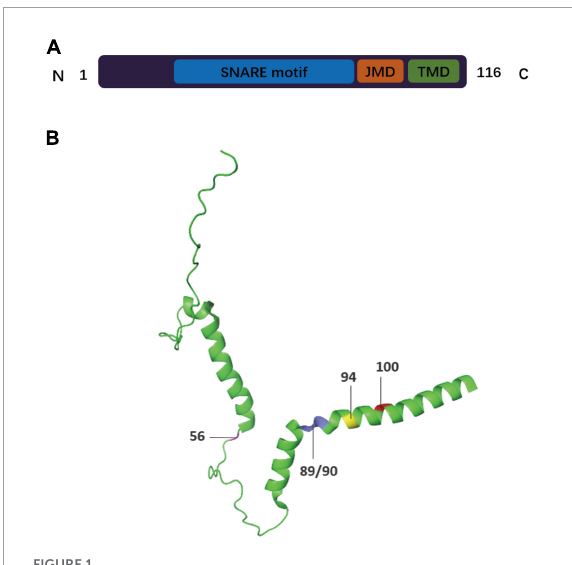
FIGURE1 Schematic drawing of the domain arrangement and 3-D structure of VAMP2. (A) The primary structure of VAMP2 is displayed in bar format. The full-length protein of VAMP2 is characterized by (i) a 94 residues-long cytosolic domain including the highly conserved SNARE motifs (residues 31–85, blue) and the dynamic juxtamembrane domain (JMD, residues 86–94, orange), (ii) a transmembrane domain (TMD, residues 95–114, green) anchoring the protein to the vesicular membrane, and (iii) a short luminal domain of only 2 residues (residues 115/116). (B) The 3D structure of VAMP2 (Protein Data Bank ID: 2KOG). The residue sites discussed in this review are denoted as follows: residue 56 Arginine (magenta), residues 89/90 Tryptophan (blue), residue 94 Lysine (yellow), residue 100 Glycine